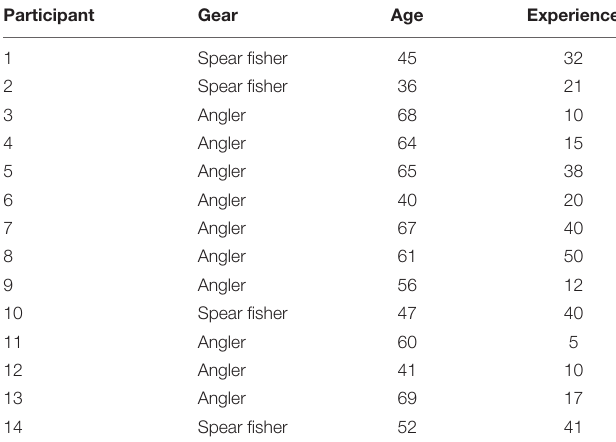
TABLE 1 | Participant characteristics ( N =